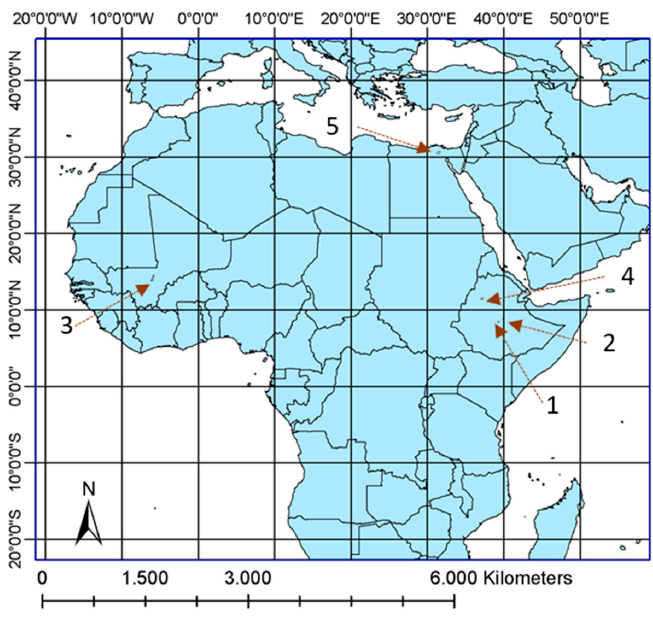
Figure 1. Location of irrigation schemes: (1) Wonji, (2) Metehara, (3) ODN, (4) Koga, (5) Zankalon.